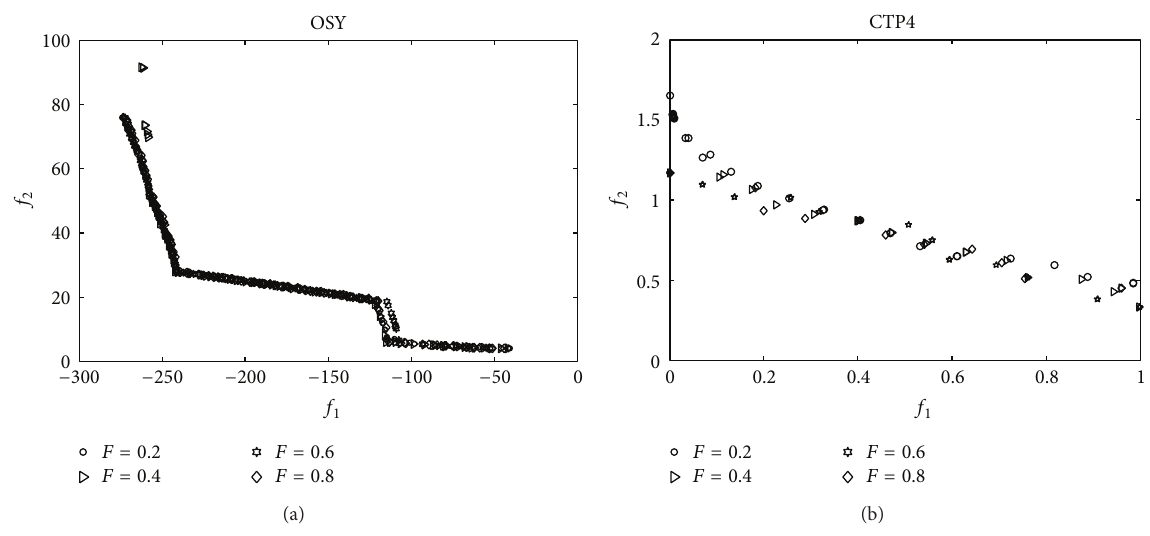
Figure 3: Final Pareto front for OSY and CTP4 under 𝐹(𝑡) = 0.2, 0.4, 0.6, 0.8